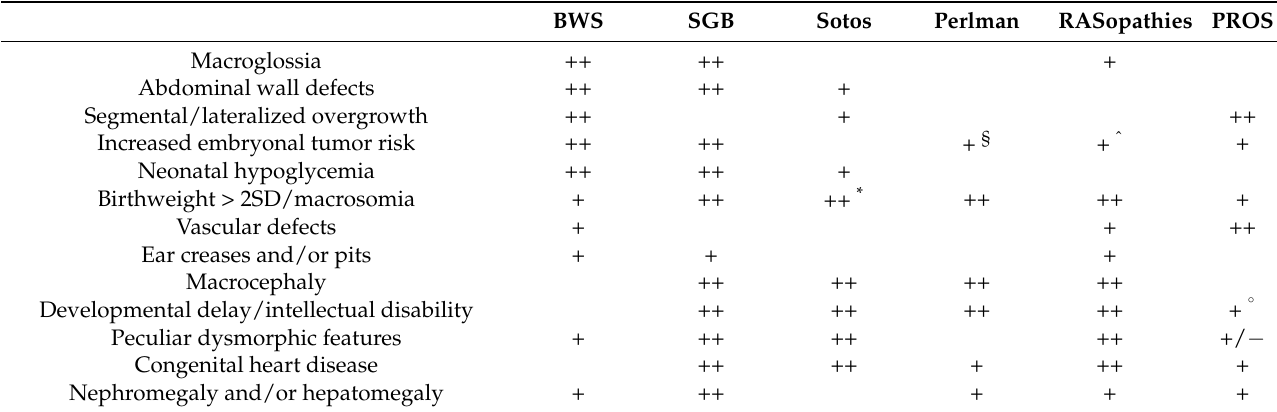
Table 4. Clinical features overlapping with BWS and syndromes that enter in differential diagnosis. BWS SGB Sotos Perlman RASopathies